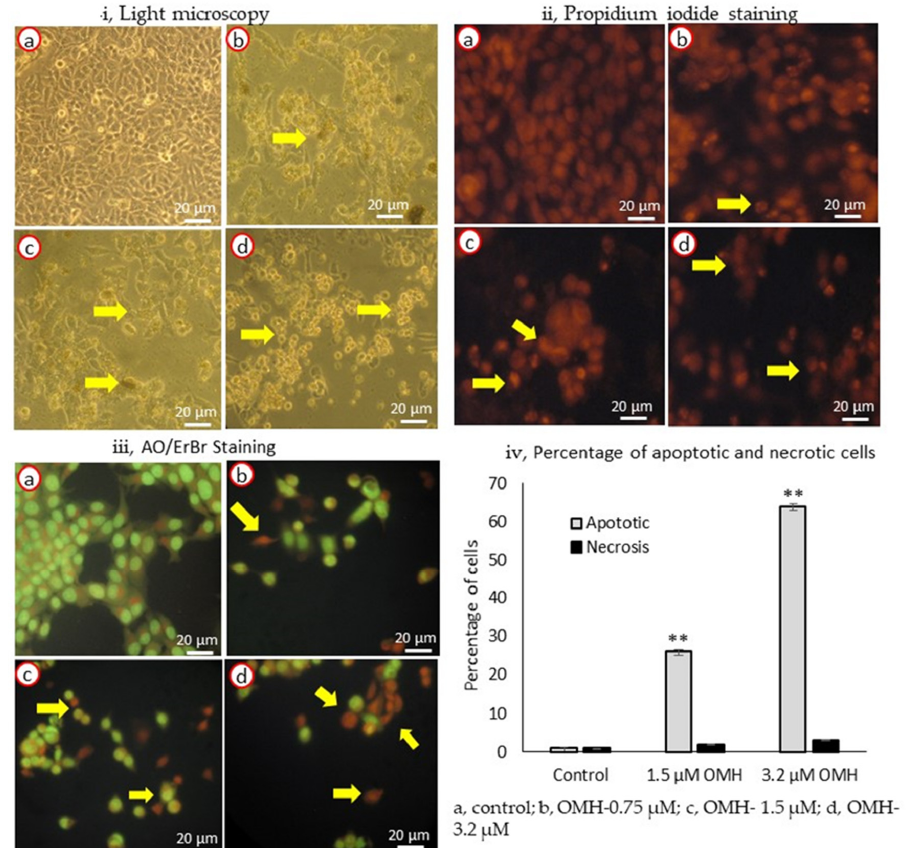
Figure 2. Light microscopy ( i ), propidium iodide ( ii ), AO/ErBr-stained ( iii ) images (40 × ) [( a ), un- treated HT-115 cells; ( b ), 0.75 µ M of OMH treatment; ( c ), 1.5 µ M of OMH treatment; and d, 3.2 µ M of OMH-treated HT-115 cells] and the percentage of apoptotic and necrotic cells in 1.5 and 3.2 µ M of OMH-treated HT-115 cell ( iv ) after 48 h. ( ii ) PI staining of 1.5 µ M ( c ) and 3.2 µ M ( d ) of OMH-treated HT-115 cells, showing stressed cells with nuclear linearization and cell death was evidenced by the morphology of abnormal nuclei and horseshoe-shaped nucleus. However, 0.75 µ M dose of OMH was not significant to apoptosis stimulation. ( iii ) AO/ErBr staining of 3.2 µ M of OMH-treated HT-115 cells ( d ) showing proapoptotic (bright green), early apoptotic (light green), late apoptotic (orange), and necrotic cells (red) are shown by arrowheads. The observed effect was higher in 3.2 µ M when compared to 1.5 µ M of OMH. In 0.75 µ M dose of OMH the majority of cells were intact and